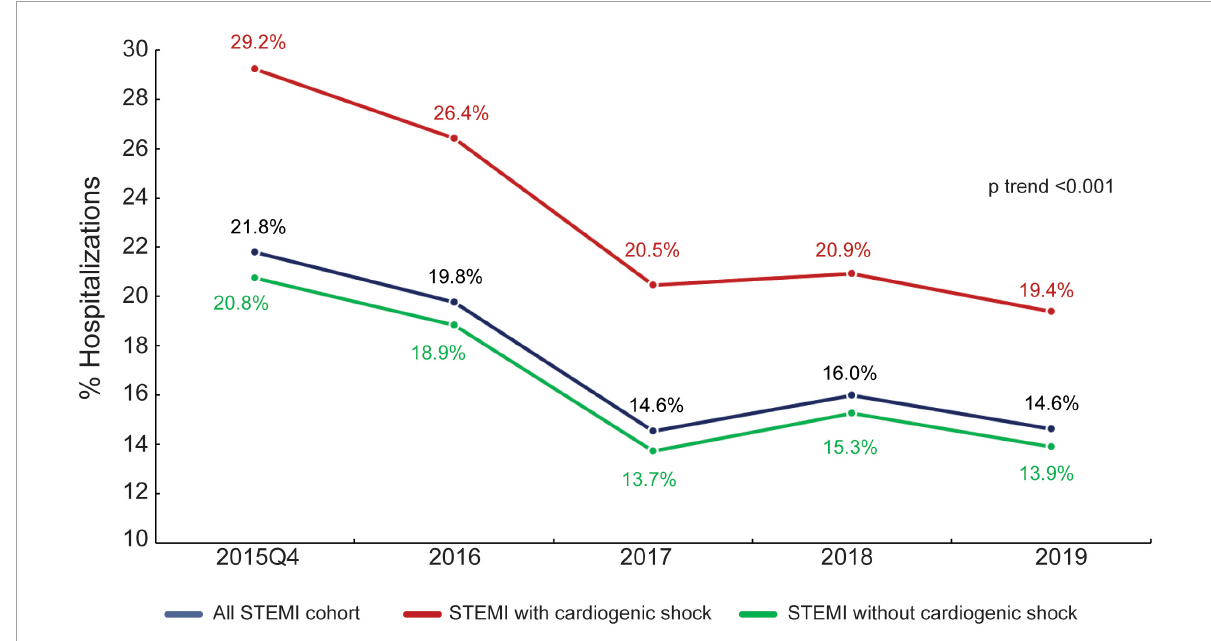
FIGURE1 Trend of multivessel PCI performance during the study period. Percentage of overall STEMI hospitalizations, STEMI hospitalizations with cardiogenic shock, and STEMI hospitalizations without cardiogenic shock in which multivessel PCI was